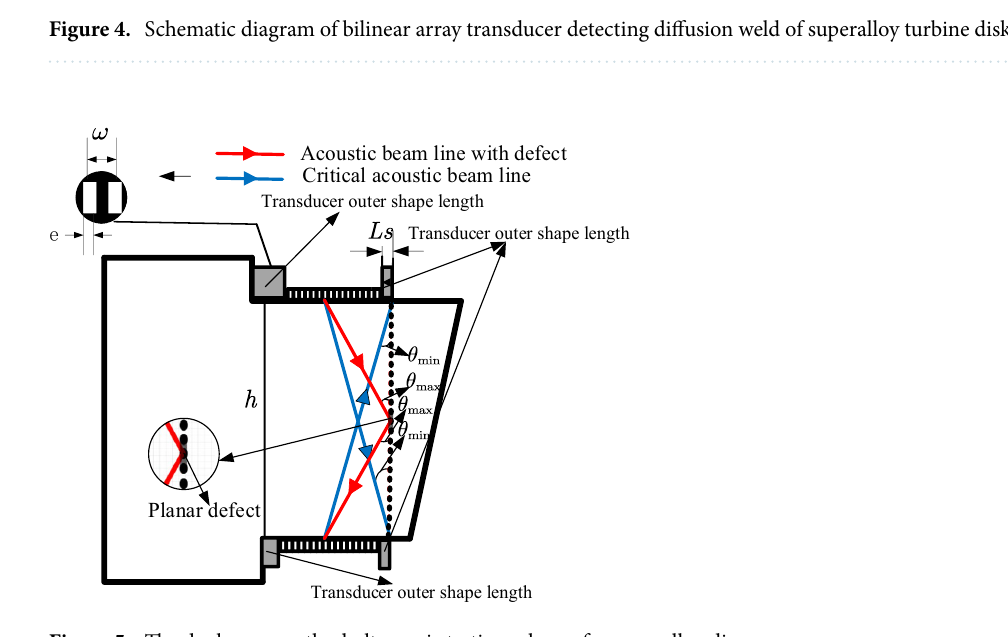
Figure 5. The dual array method ultrasonic testing scheme for superalloy